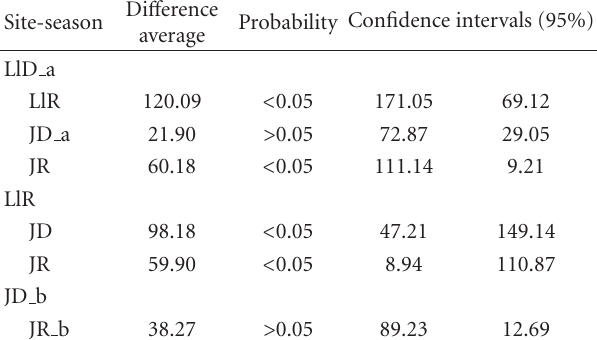
Table 2: Results of multiple comparison LSD tests for ant foraging during dry and rainy season in two sites, Jard´ın and Llano. α = 0 . 05. LlR: Llano rainy; LlD: Llano dry; JR: Jard´ın rainy; JD: Jard´ın dry. Distinct letters indicate significant di ff erences.